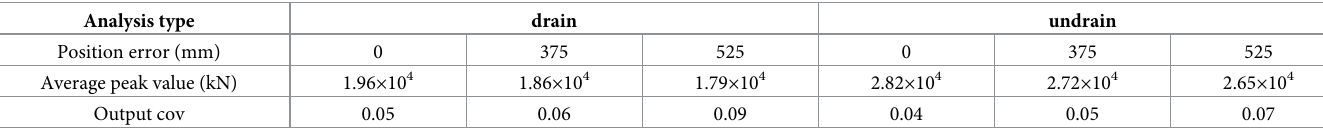
Table 3. Parametric studies in random